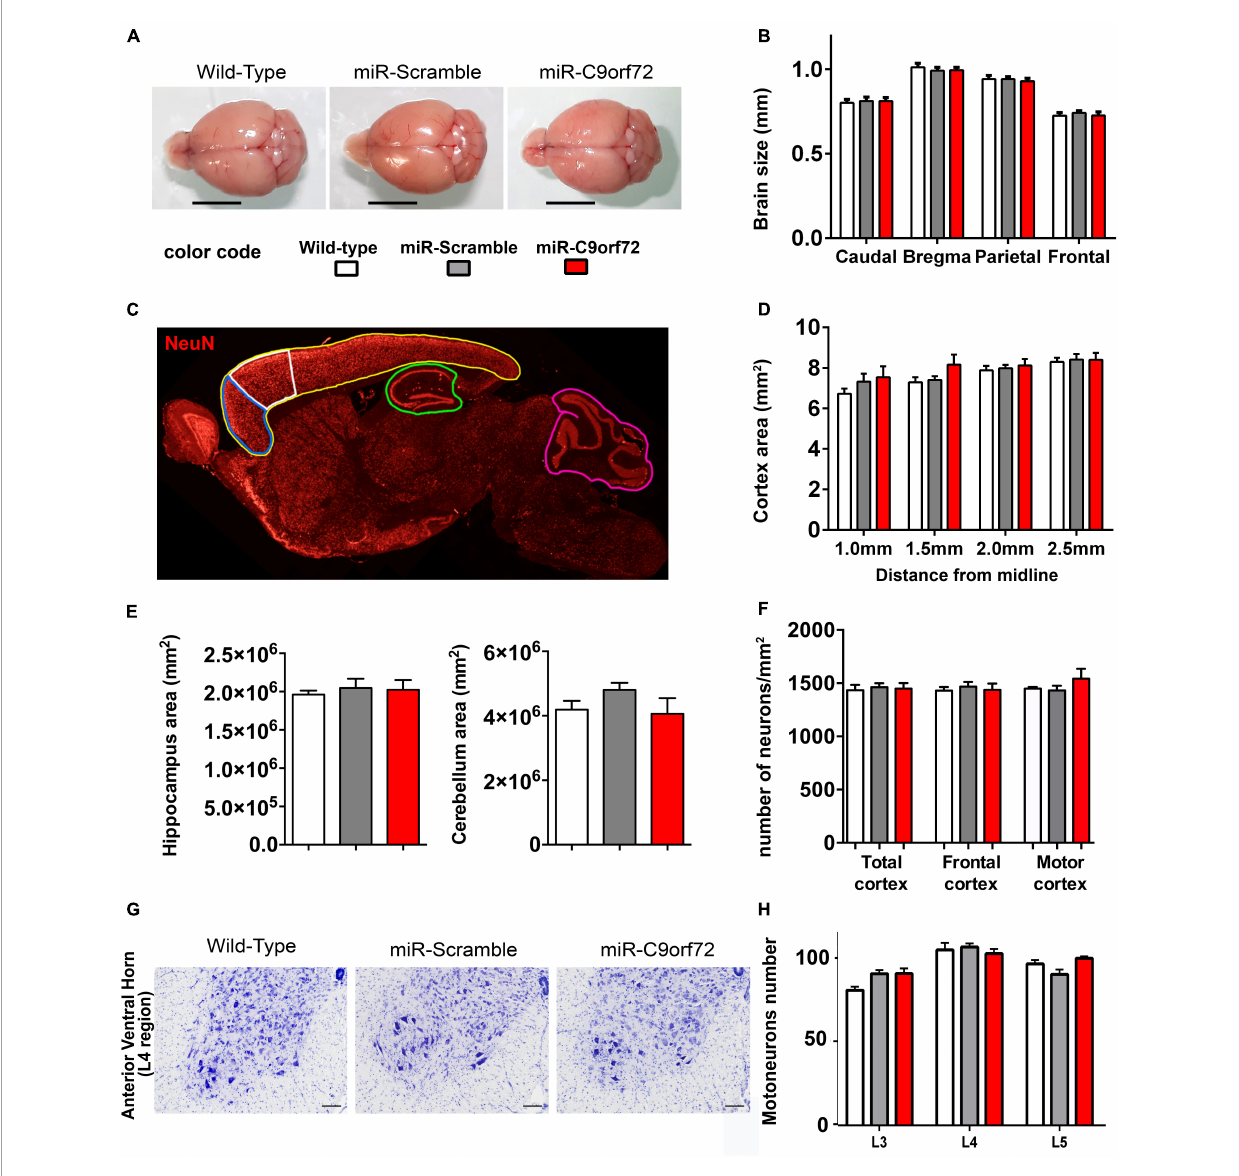
FIGURE2 C9ORF72 deficient mice do not present brain atrophy or neurodegeneration. (A) Representative examples of adult brains of miR-C9orf72, miR-Scramble and wild-type mice at 18 months. Scale bar = 5 mm. (B) Macro-measurements of brain width at caudal, bregma, parietal and frontal positions (wild-type n = 4; miR-Scramble n = 4, miR-C9orf72 n = 6). (C) Areas of the brain analyzed: total cortex (yellow), frontal cortex (blue), motor cortex (white), hippocampus (green), and cerebellar (pink) (wild-type n = 4; miR-Scramble n = 4, miR-C9orf72 n = 6). (D) Quantification of the total cortical surface between 1 and 2.5 mm from interaural line. (E) Quantification of the total hippocampal (left) and cerebellar (right) surface at 2 mm from interaural line. (F) Quantification of NeuN-positive cells in the whole cortex area (total cortex) and specifically in the frontal cortex and motor cortex, 2 mm from interaural line. wild-type n = 4; miR-Scramble n = 4, miR-C9orf72 n = 6. (G) Anterior ventral horn sections of C9ORF72 deficient mice and controls at 22 months of age stained with Cresyl Violet (Nissl staining). Scale bar = 200 µ m. (H) Quantification of motor neurons in L3,